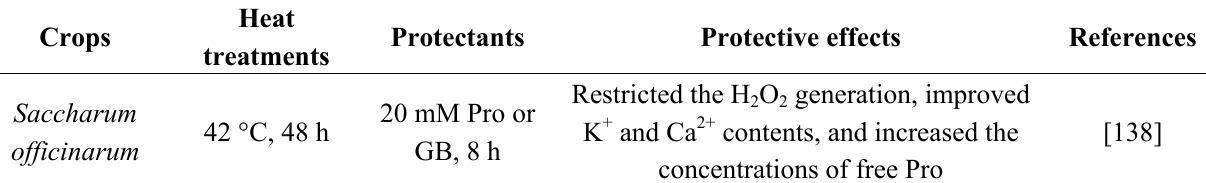
Table 2. Protective effects of exogenous molecules under different heat stress conditions.